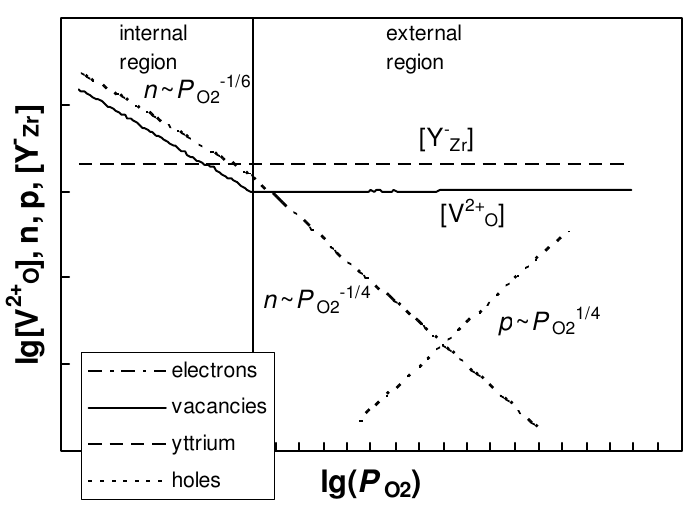
Fig. 8 Schematic dependence of the concentrations of electrons, vacancies, yttrium cations, and holes on the oxygen pressure in YSZ